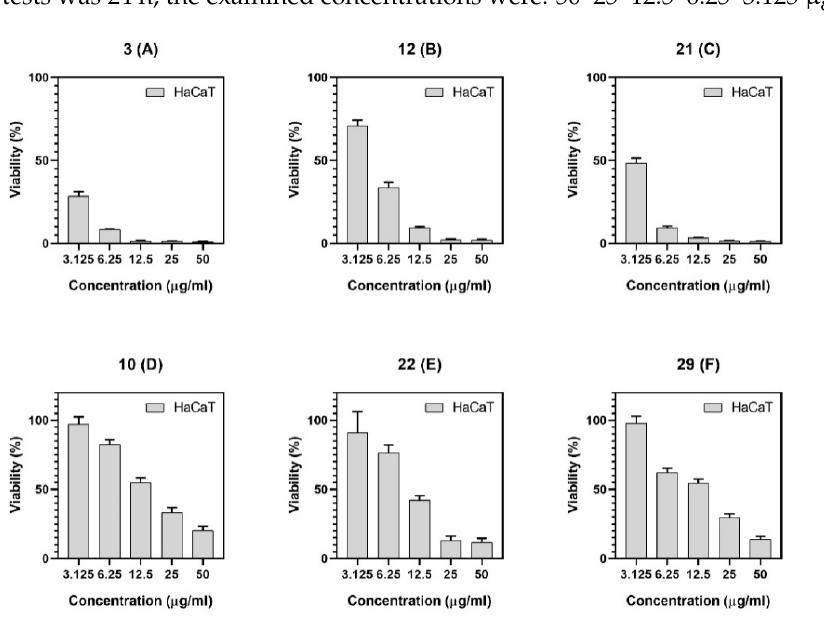
Table 4. Cytotoxic activity of compounds 3 , 10 , 12 , 21 , 22 and 29 on HaCaT cells.